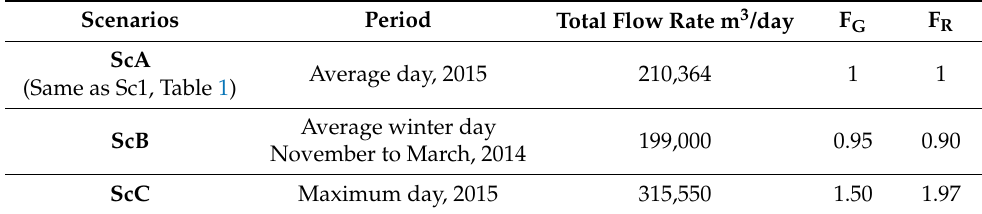
Table 2. Scenarios for investigating the self-cleaning